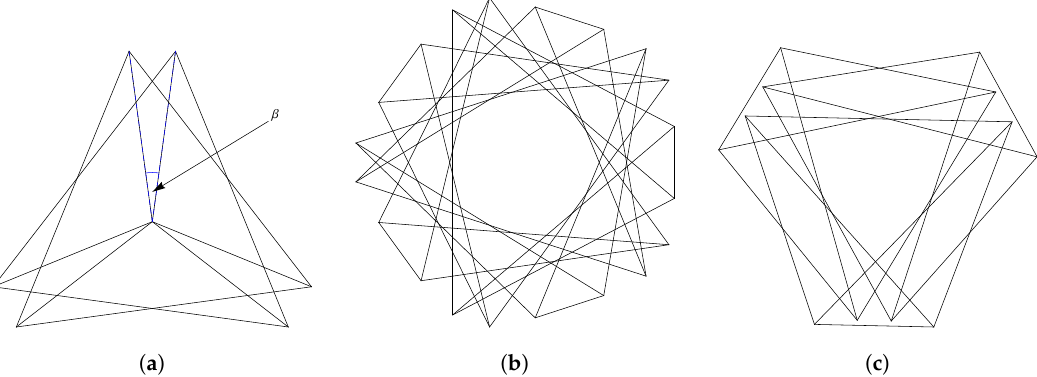
Figure 5. BC helix projections and face junction. ( a ) A “face junction” between tetrahedra of a 3- or 5-BC helix. ( b ) A projection of the 5-BC helix along its central axis, showing five-fold symmetry. ( c ) A projection of the 3-BC helix along its central axis, showing three-fold symmetry.